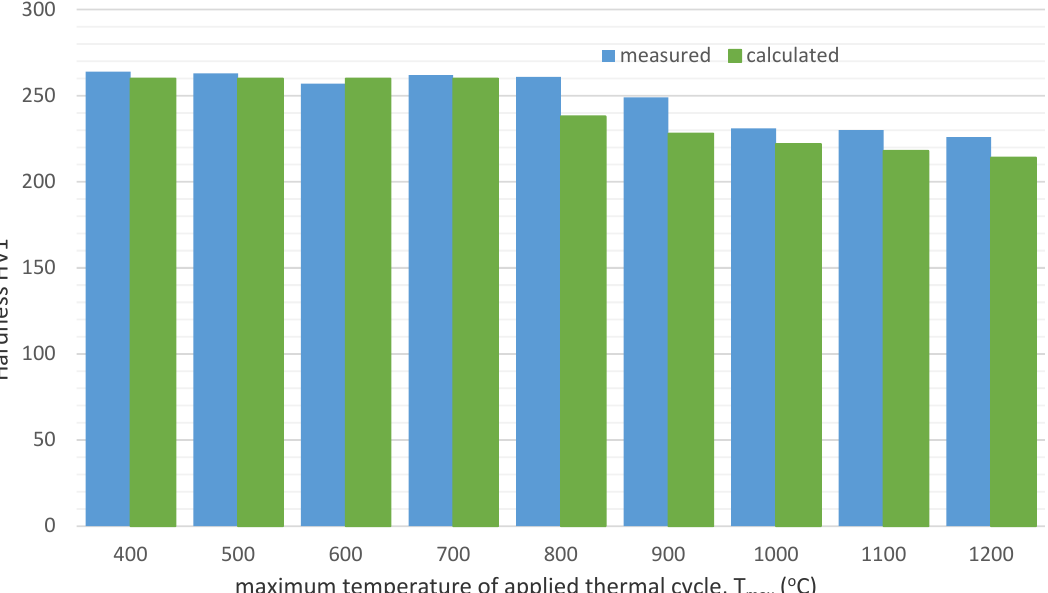
Figure 12. Comparison of the real and calculated results of measurements of hardness in thermo-